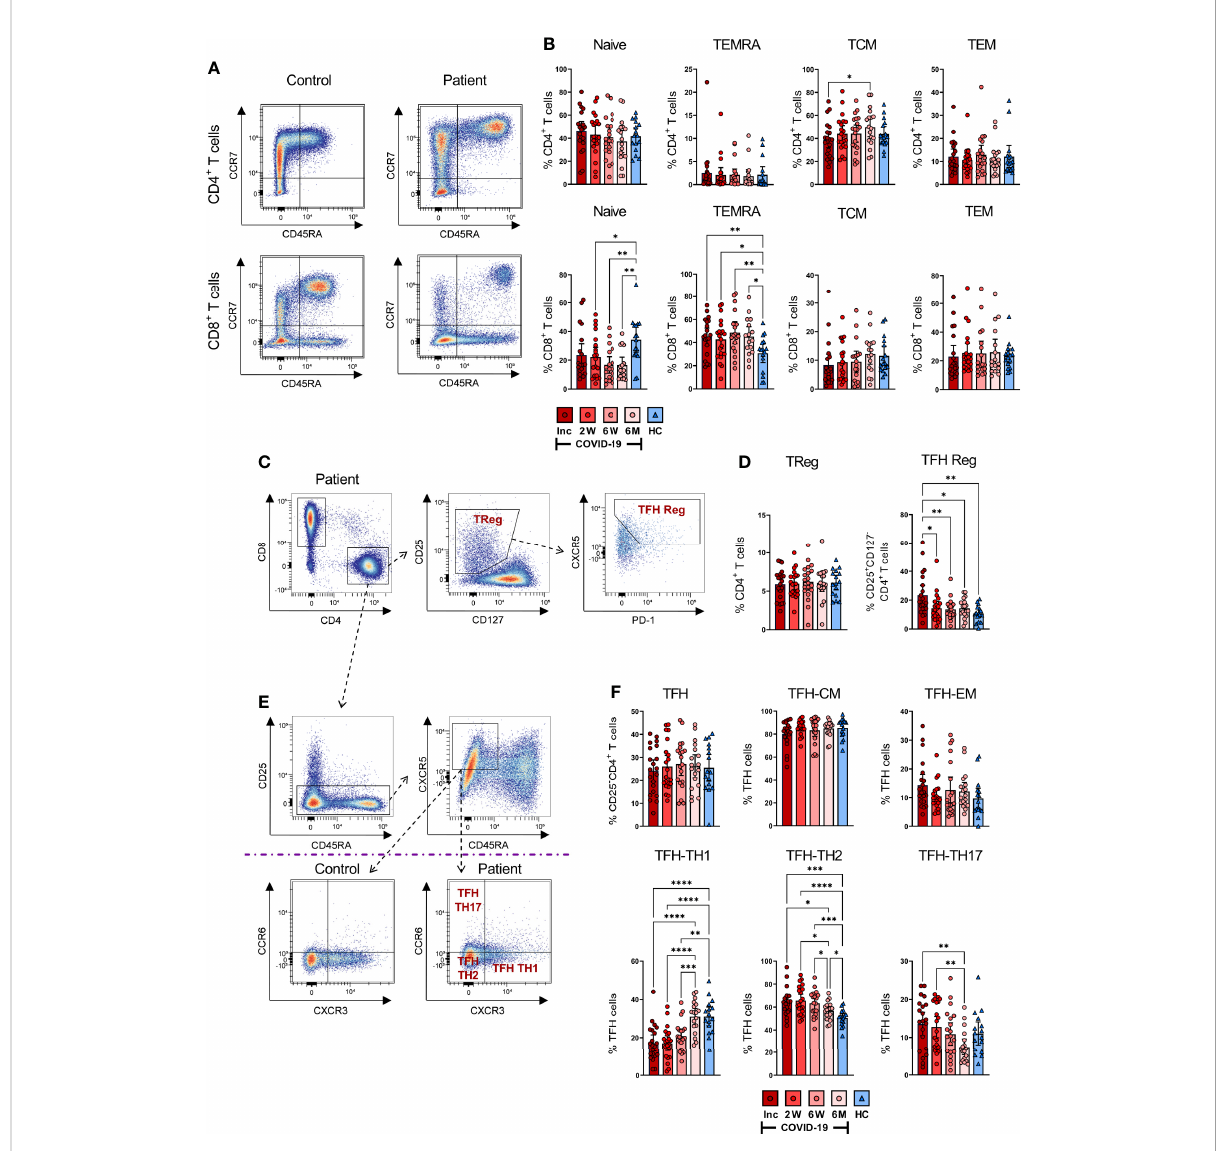
FIGURE 3 SARS-CoV-2-speci fi c CD4 + and CD8 + T cell subsets during COVID-19 infection. PBMCs were collected from COVID-19 patients that needed hospitalization (N=23) and healthy controls (N=16) over a 6-7 month period. Cells were stained with antibodies for fl ow cytometry to immunophenotype the various T cell populations. (A) Representative fl ow plot of CD4 + (upper panel) and CD8 + (lower panel) naïve and memory T cell populations. (B) Percentages of naïve (CCR7 + CD45RA + ), TEMRA (CCR7 - CD45RA + ), TCM (CCR7 + CD45RA - ), and TEM (CCR7 - CD45RA - ) subsets in CD4 + (upper panel) and CD8 + (lower panel) T cells. (C) Representative gating strategy of CD4 + Tregs (CD25 + CD127 - ) and TFH Reg (CXCR5 + PD-1 + CD25 + CD127 - ) on CD4 + T helper cells. (D) Fractions of Tregs (left panel) and TFH Regs (right panel). (E) Representative gating and (F) proportions of TFH-TH1, TFH-TH2, and TFH-TH17. Data is represented as mean with 95% Cl, with signi fi cance of *p ≤ 0.05, **p ≤ 0.01, ***p ≤ 0.001, ****p ≤ 0.0001., determined using Brown-Forsythe and Welch ANOVA tests. Inc = Inclusion in study at the hospital, 2W = 2 weeks, 6W = 6 weeks, 6M = 6-7 months, HC = healthy